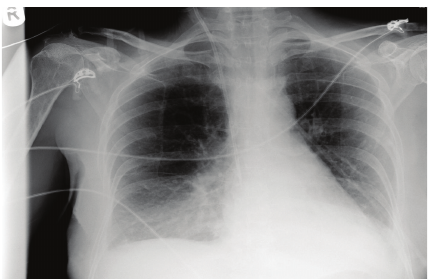
Figure 2: Chest radiograph taken of patient 2 showing right lower lobe consolidation consistent with